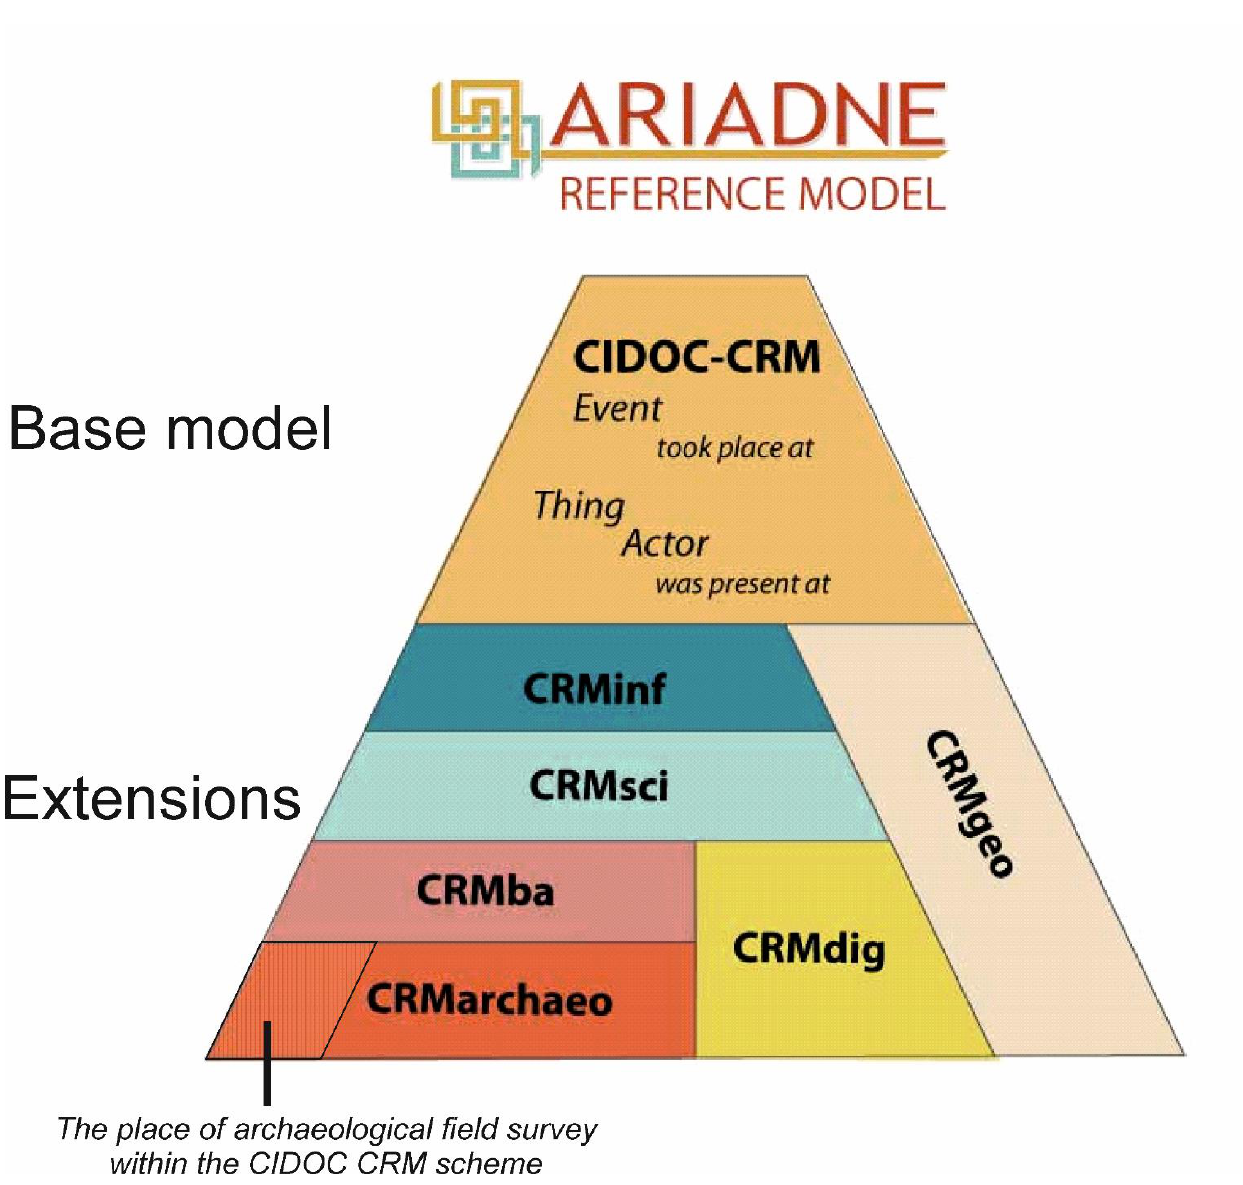
Fig. 1. The ARIADNE reference model (modified from